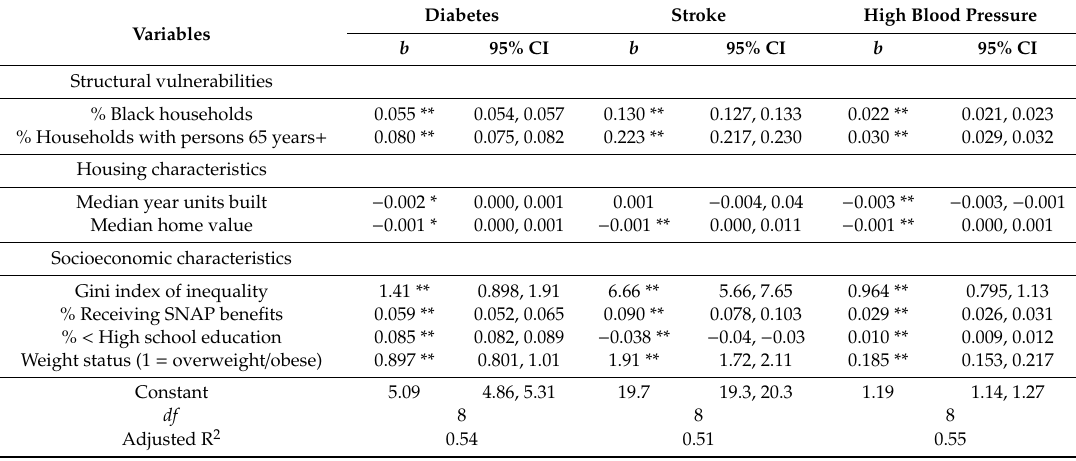
Table 2. Crude chronic disease prevalence regression models in the 500 largest U.S. cities, 2015. Diabetes Variables